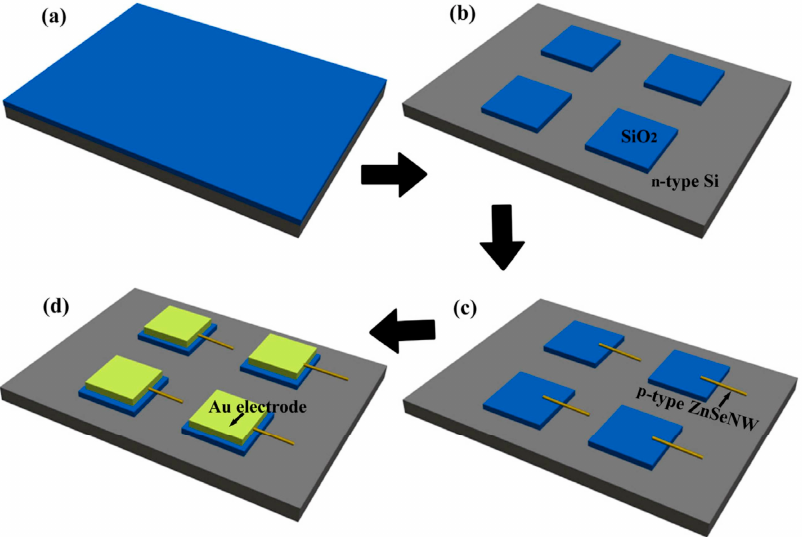
Figure 8. Schematic illustration of the fabrication process of ZnSeNW/Si p-n junction. Reproduced with permission from [44], Copyright 2016, Elsevier B.V.